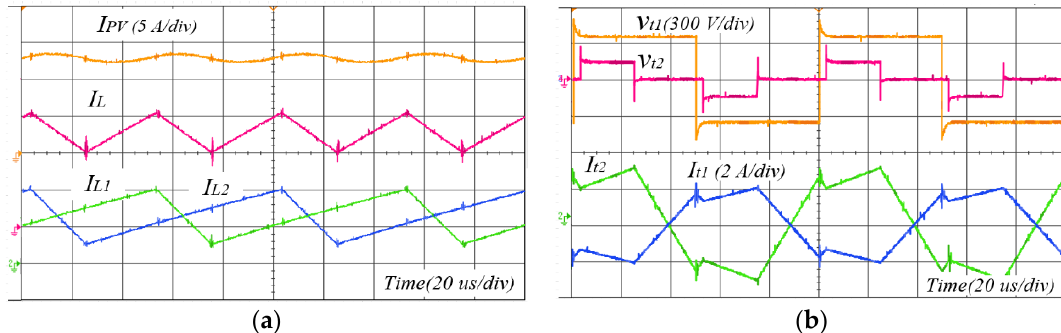
Figure 13. ( a ) the current in the interleaved boost converter and the PV output current and ( b ), the current and voltage waveforms in winding one and two of the transformer.